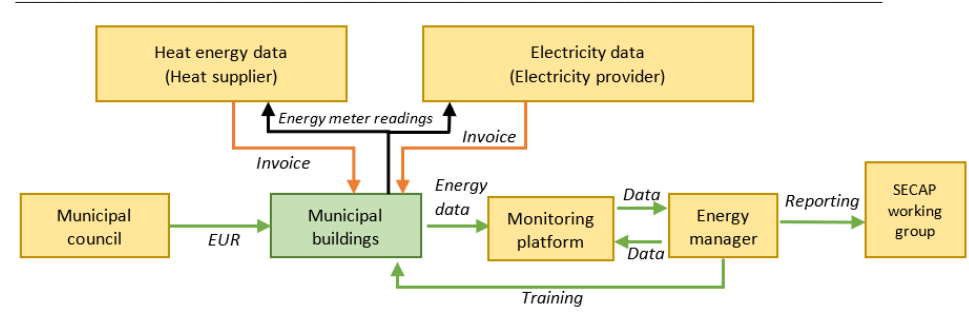
Fig. 5. Energy consumption data management system in Daugavpils municipal buildings after